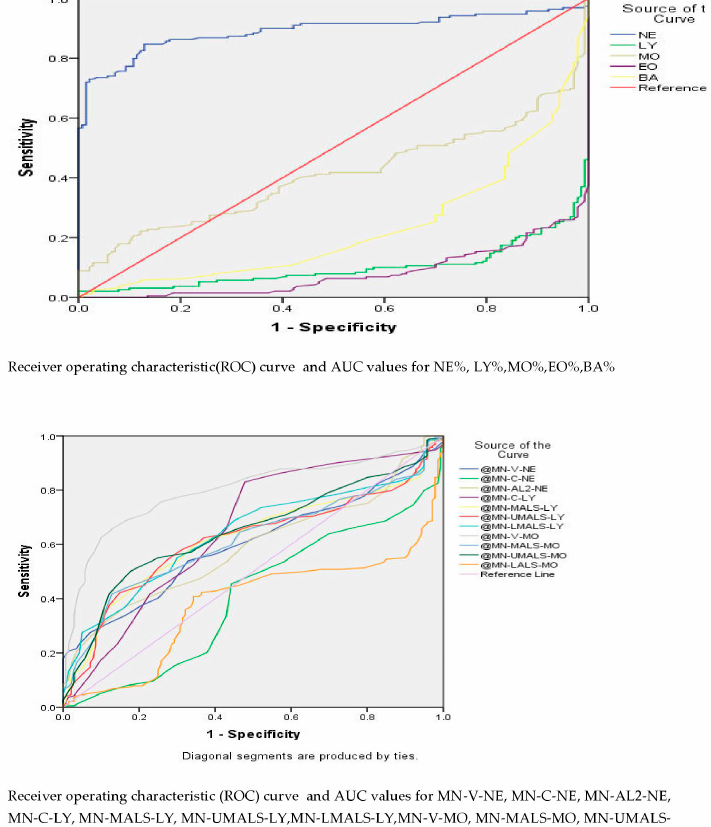
Figure 1. ROC curve for COVID-19 against healthy controls. Table 3. Comparison of hematological parameters of COVID-19 patients and non-COVID-19 Influenza-like